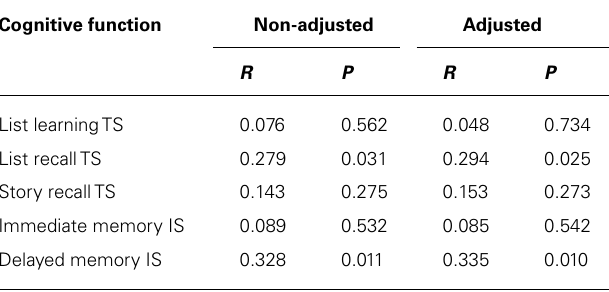
The left panel of the table illustrates the results of the regression coefficients for the changes of RNFL thickness and cognitive function in a simple linear regres- sion. The right panel of the table shows the regression coefficients in multiple linearregressionsincludingadjustmentofage, gender, education, bloodglucose, and cholesterol levels.TS, test score; IS, index score.